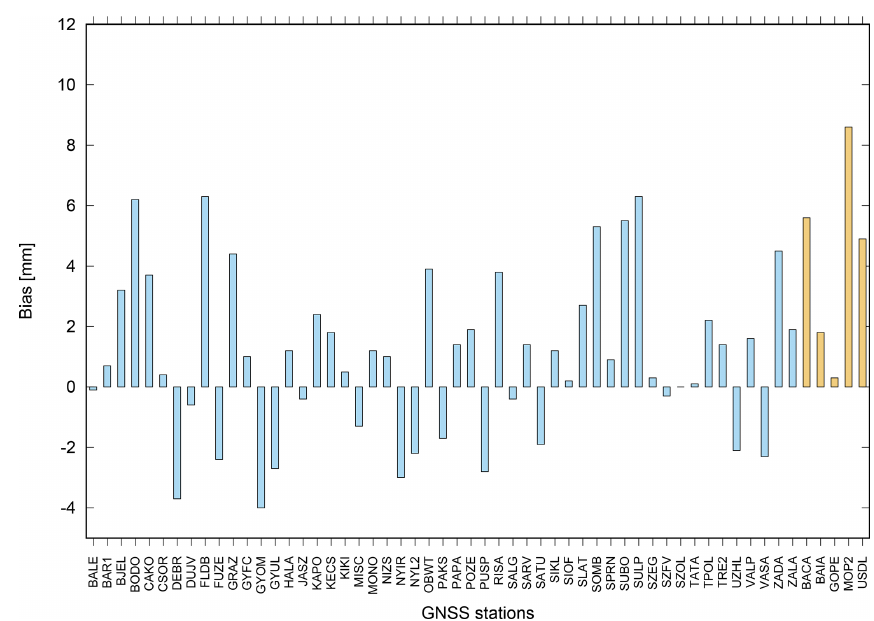
Figure 6. The ZTD bias in millimetres for SGO1 (light blue) and WUEL (light orange) networks calculated for the period of 15–31 May 2017.